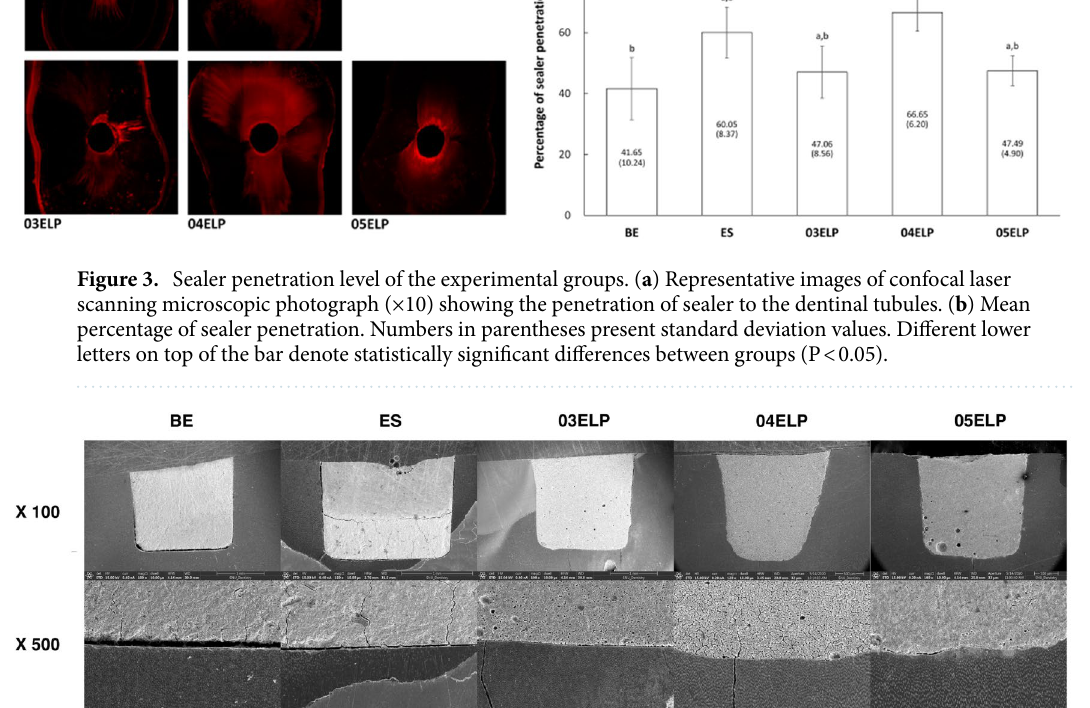
Figure 4. Representative SEM images of the dentin-sealer interface: low magnification (×100) of the experimental sealers in upper row and high magnification (×500) of the experimental sealers in lower row. ELP- based MTA sealers show more intimate contact with dentin compared to commercial MTA sealer